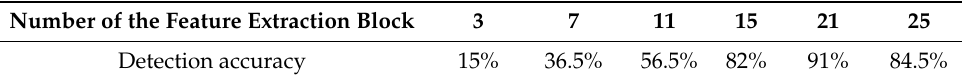
Table 2. The influence on the detection ability of the detection model under different numbers of feature extraction blocks.